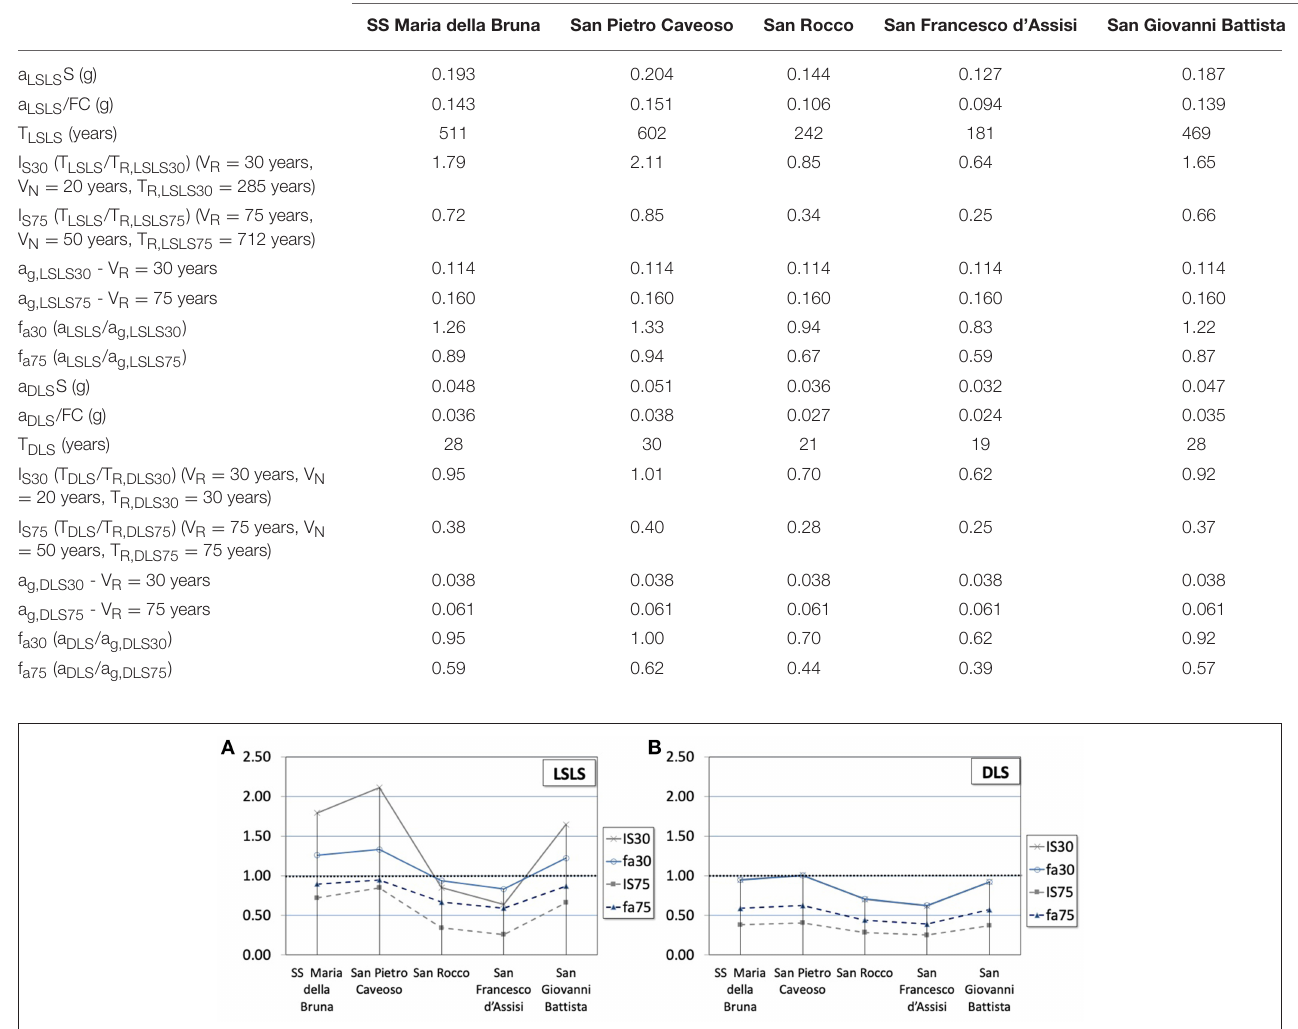
FIGURE 3 | Indexes calculated with the LV1 method for (A) LSLS and (B) DLS.